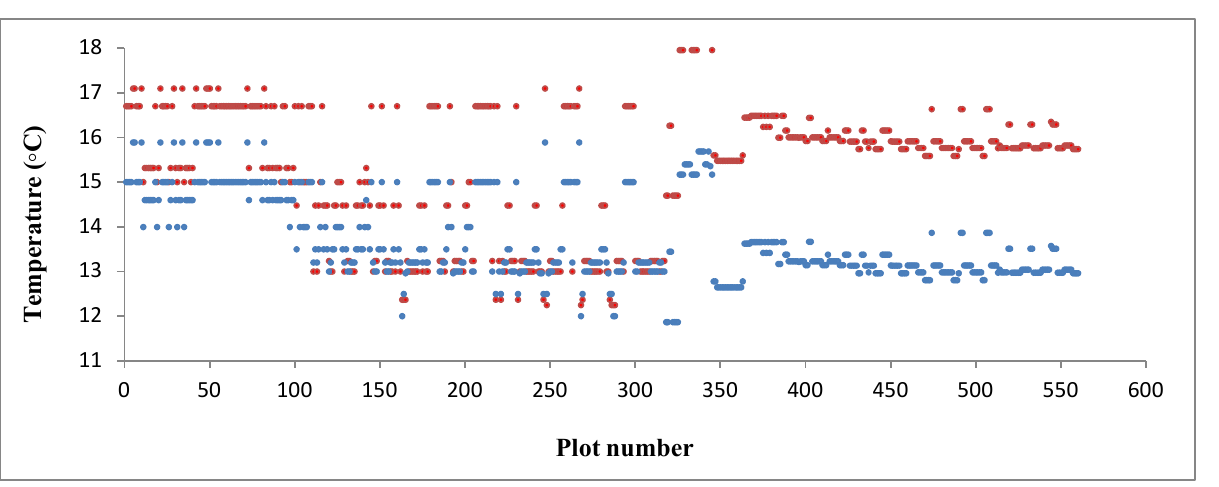
Figure 5. The trend of annual temperature changes at the beginning (blue points) and end (red points) of the period in the studied plots.